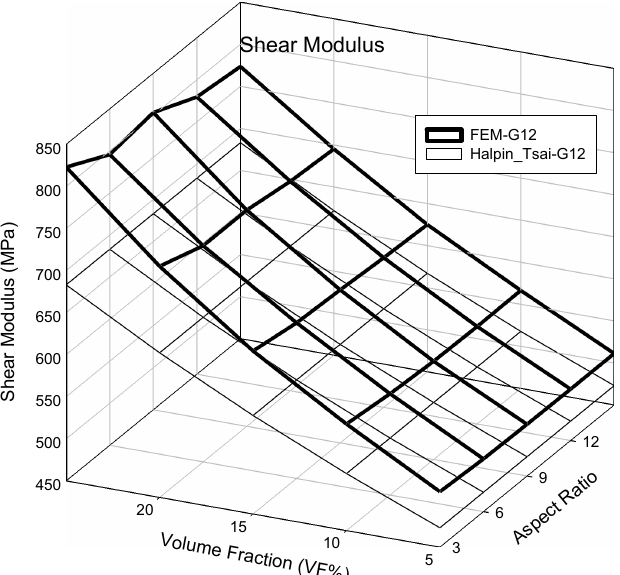
Figure 5. Shear modulus result based on volume fraction and aspect ratio. A contour graph (see Figure 6) was constructed to derive the elastic modulus based on the volume fractions and aspect ratios used in the finite element analysis. A contour graph is used to represent a 3D curved surface on a 2D plane. In particular, when 3D points are represented by (x, y, z), for a specified z value, a curve connecting the points (x, y) that corresponds to this value is known as a contour line. Two methods can be used to draw contour lines, i.e., using a rectangular mesh constructed by the intersection of par- allel grid lines, and using a triangle mesh constructed by connecting the diagonals of squares. Contour lines can be useful for expressing the data obtained via tests and meas- urements in two dimensions. As x and y are continuous values, a value exists between the lattices, which can be obtained easily via interpolation. Even if missing values occur in the data, they can be replaced by interpolation. To exploit the advantages of such interpola- tions, the result of the finite element analysis was analyzed based on the contour graph. First, to calculate the physical properties of the longitudinal elastic modulus (E 11 ) of the PP/UHMWPE composite material reinforced with UHMWPE fiber, using Figure 6, the modulus of elasticity can be calculated based on the aspect ratio and volume fraction. Based on Figures 4 and 6, the modulus of elasticity in the longitudinal direction increased with the aspect ratio and volume fraction of the UHMWPE fiber-reinforced composite material. The area denoted by ① in Figure 6 is the area where the result of the finite ele- ment analysis agrees well with the result of the Halpin–Tsai model. To predict the aspect ratio and volume fraction of the UHMWPE fibers in this area, the longitudinal elastic properties of the fibers can be used, which can be easily predicted using the Halpin–Tsai model. Figure 7 shows the change in the transverse elastic modulus (E 22 ) of the UHMWPE fibers calculated via the finite element analysis. The results show that the modulus of elas- ticity in the direction perpendicular to the UHMWPE fiber increased proportionally to the aspect ratio, although it was not affected significantly by the volume fraction of the fiber. Additionally, the modulus of elasticity in the orthogonal direction of the fiber decreased slightly as the volume fraction increased. However, based on the Halpin–Tsai model, the orthogonal elastic modulus of the fiber was affected only by the aspect ratio of the UHMWPE fiber, i.e., the volume fraction did not exert any effect. As shown in region ① of Figure 7, the orthogonal elastic modulus of the fiber obtained via the finite element analysis and the Halpin–Tsai model matched well, regardless of the aspect ratio of the fiber until the volume fraction of the UHMWPE fiber was 13. However, as the volume fraction increased, the results of the Halpin–Tsai model deviated from those of the finite